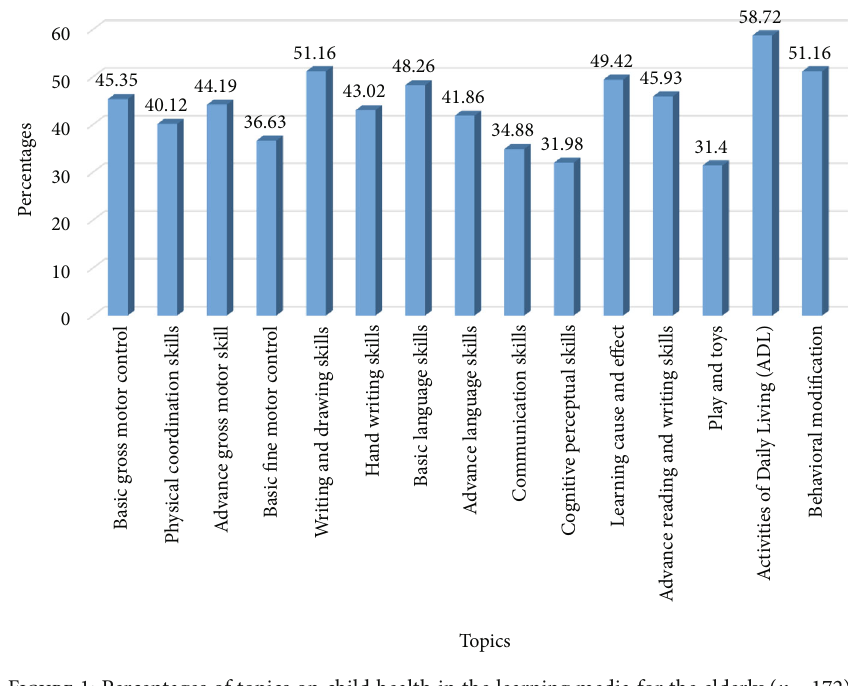
Figure 1: Percentages of topics on child health in the learning media for the elderly ( n = 172 ).